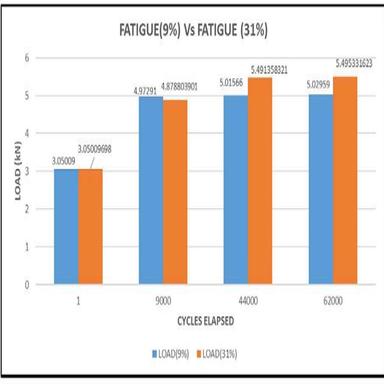
Comparative Fatigue Analysis of NMMC (9%) Vs NMMC (31%).